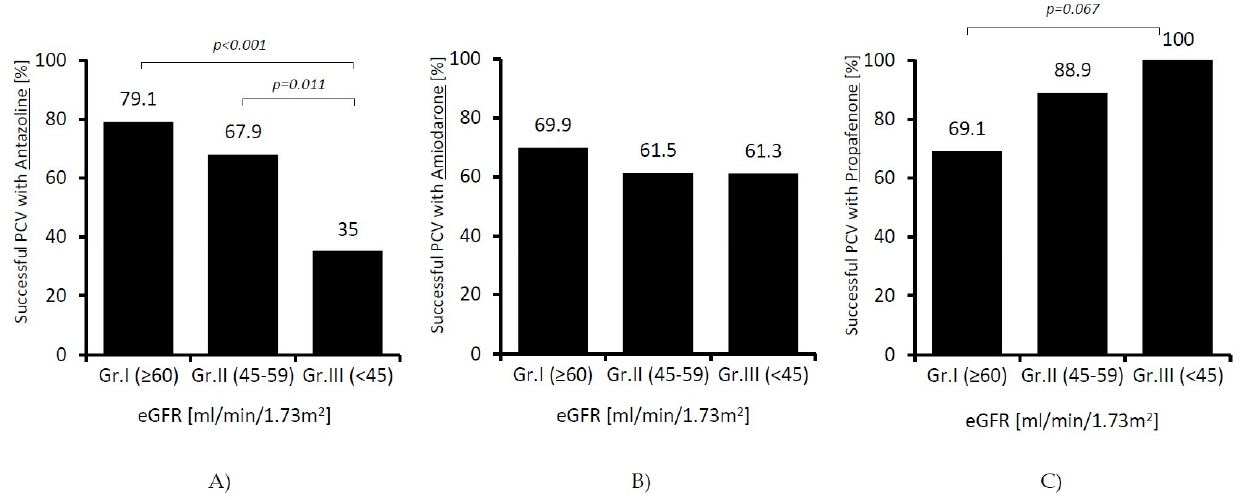
Figure 2. Effectiveness of pharmacological cardioversion (PCV) with antazoline ( A ), amiodarone ( B ), and propafenone ( C ) at different stages of chronic kidney disease (patients: Group I n = 531; Group II n = 149; Group III n =